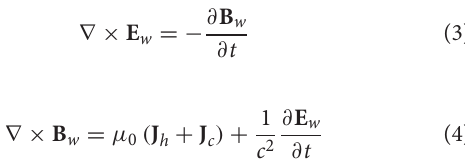
FIGURE 6 | Geometry showing resonant currents and particle perpendicular velocity relative to the wave fields (E w , B w ) and background geomagnetic field (B 0